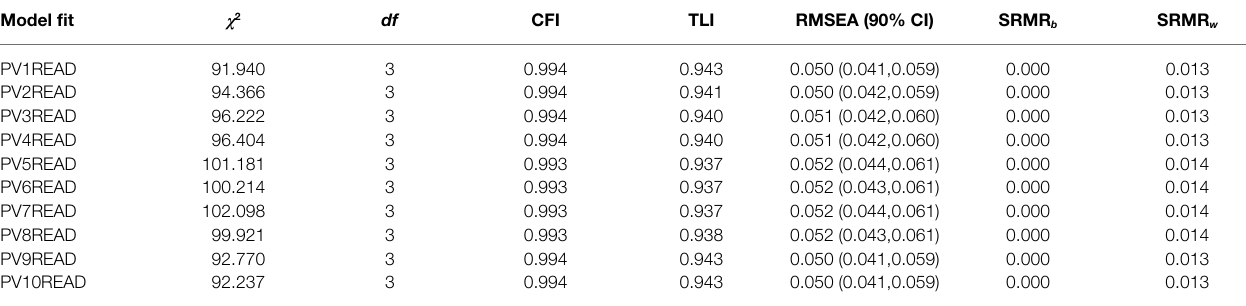
TABLE 5 | Fit indices for Model 3 . Model fit